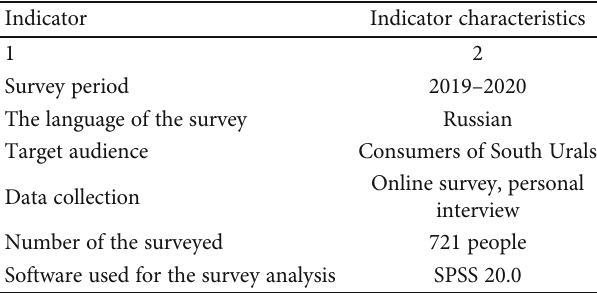
Figure 1: Working model and expected correlations (Hi: hypotheses). Table 1: Characteristics of the